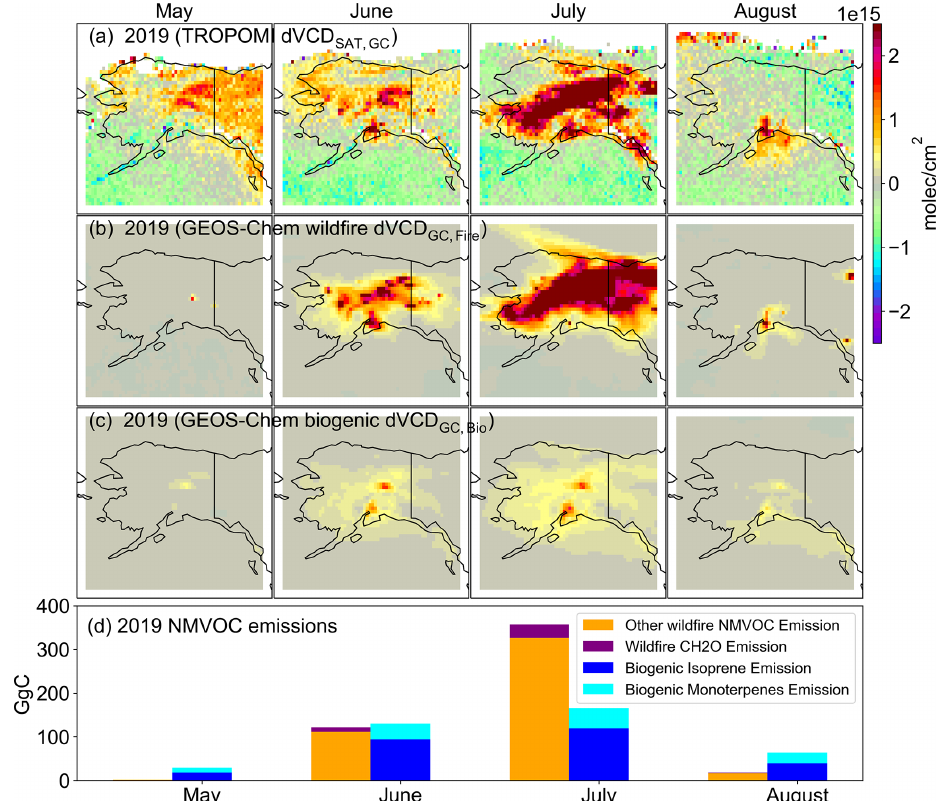
Figure 5. HCHO dVCD and emission in Alaska in summer 2019. Similar to Fig. 3 but for 2019. The y -axis range of (d) is larger than that in Fig.